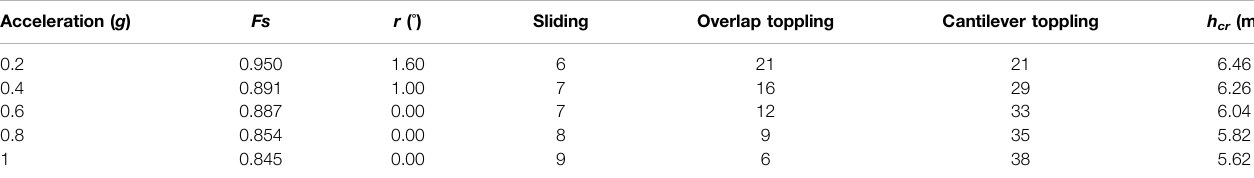
TABLE 2 | Stability and zoning of the anti-dip rock slope in southern Anhui under different seismic loads. Acceleration ( g ) Fs Sliding Overlap toppling